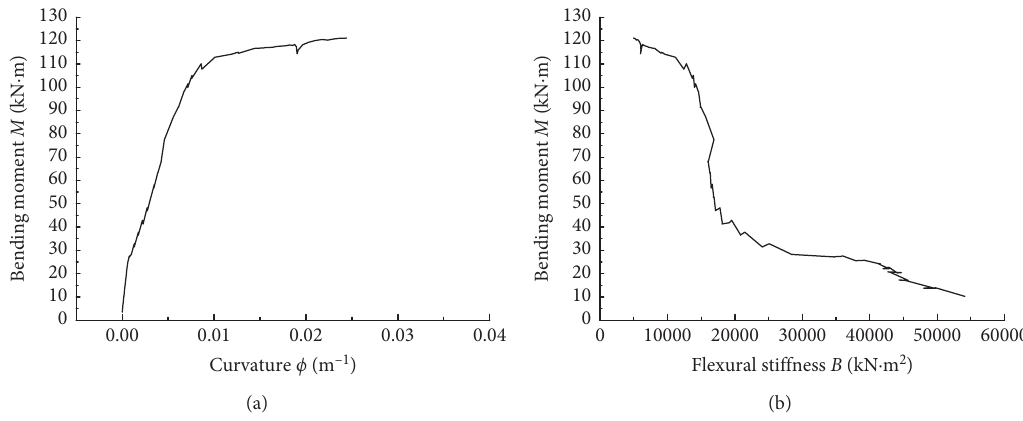
Figure 9: B-1-30-6. (a) Bending moment-curvature curve. (b) Bending moment-stiffness curve.